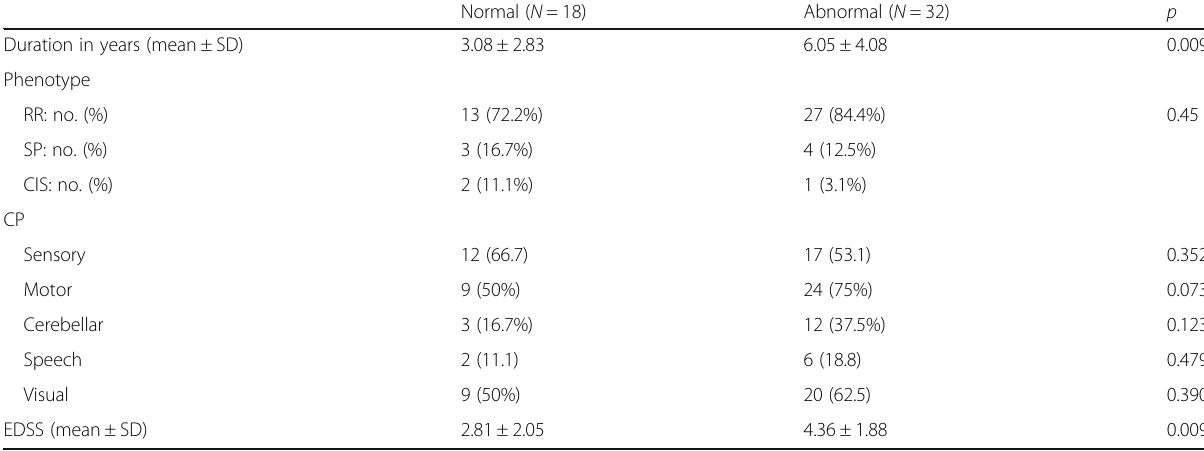
Table 2 Clinical